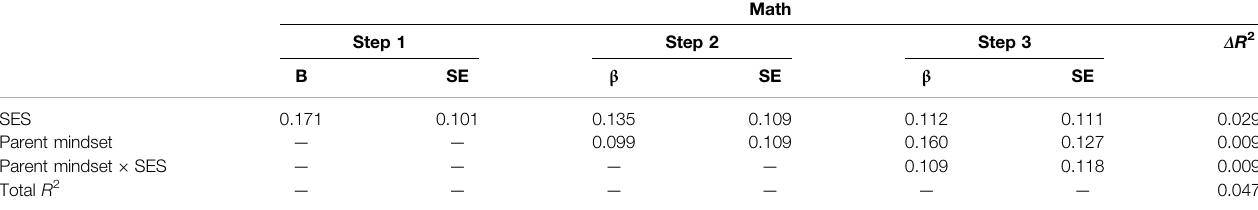
TABLE 7 | Results from regression models (research question 3 and 4 regarding math